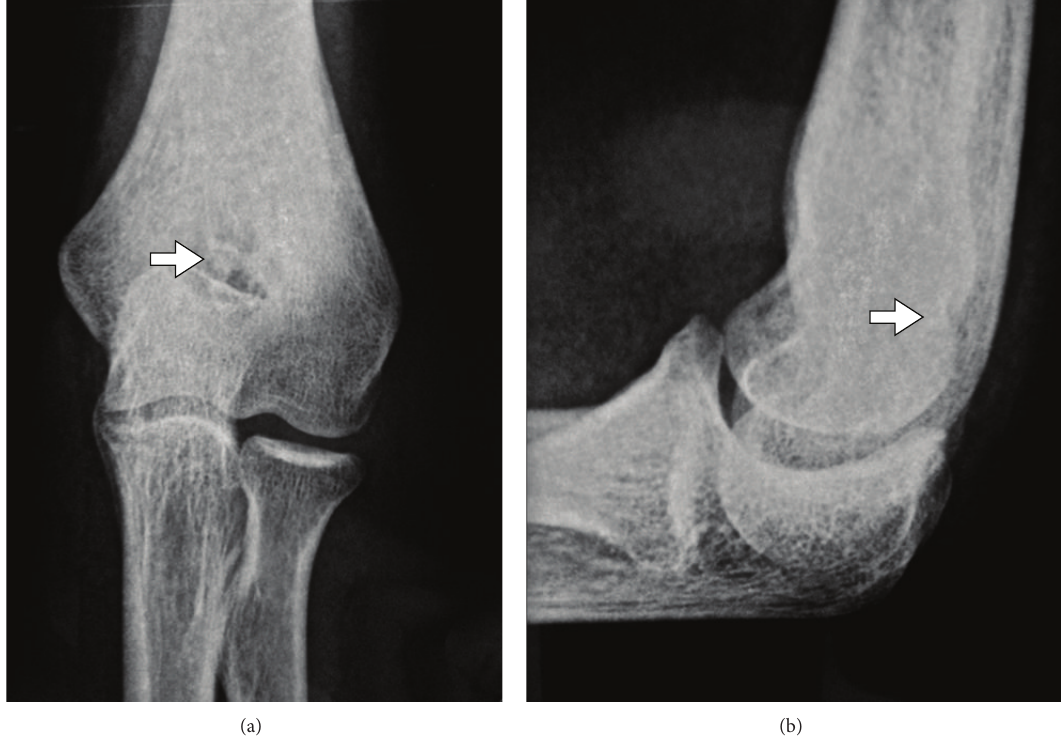
Figure 1: AP/lateral plain radiograph: a nidus in olecranon fossa humeri with small central sclerosis surrounded by reactive sclerosis.